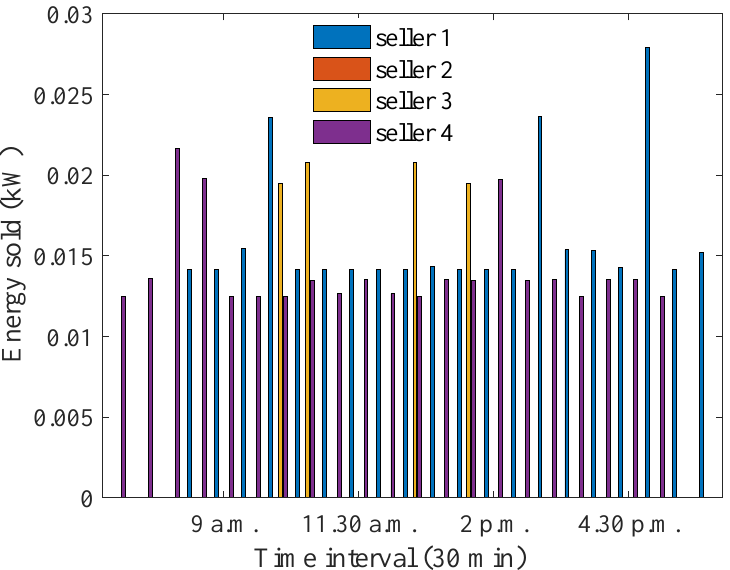
Figure 27. Optimum energy sold when profit threshold is increased to a larger value.